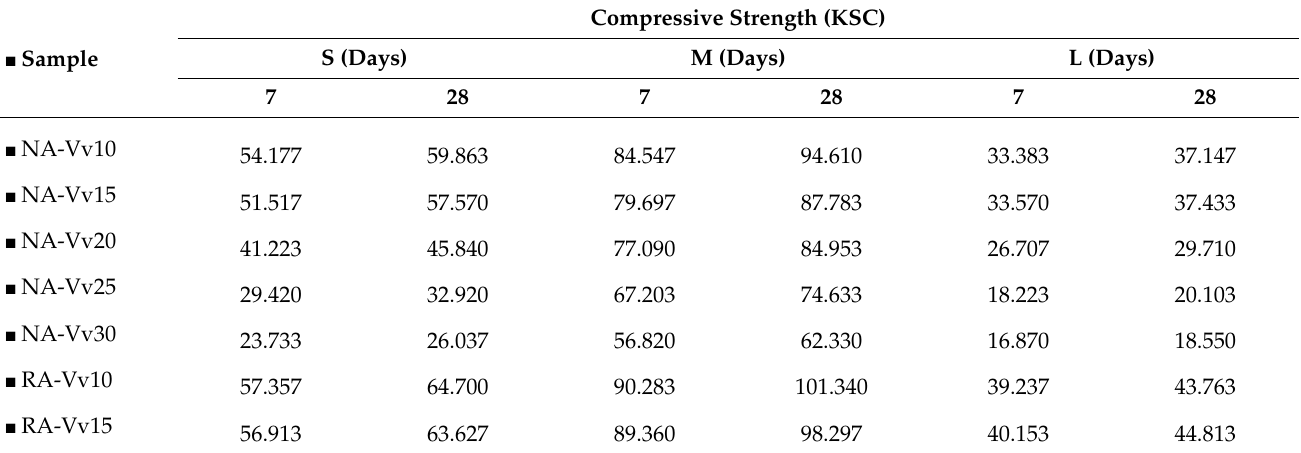
Table 5. Unit weight and water absorption characteristics of natural and recycled